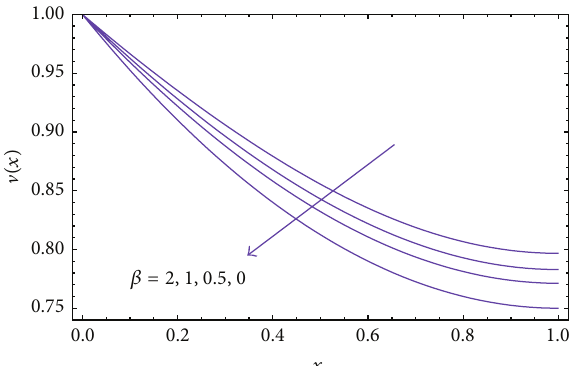
Figure 2: Effects on velocity profile for various values of 𝛽 at 𝑚 = 0 . 5.